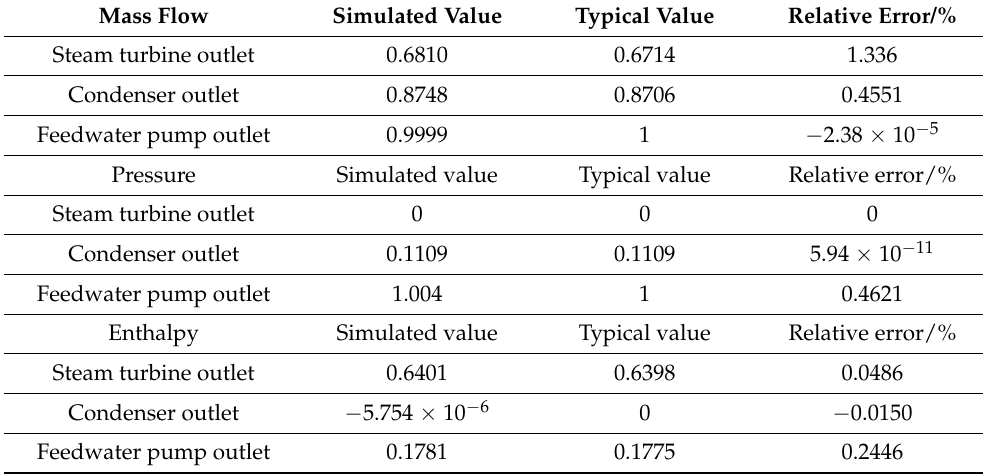
Table 2. Comparison between numerical results and typical